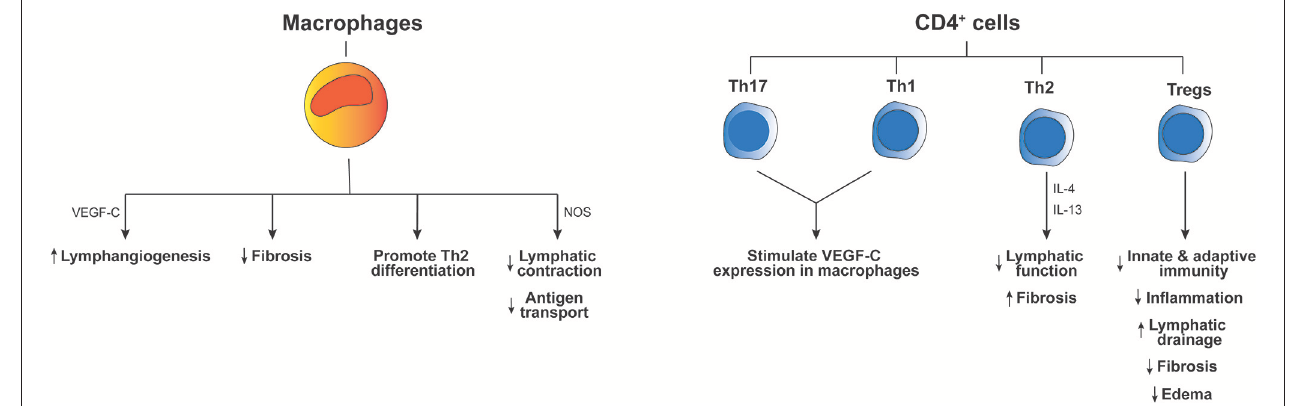
FIGURE 1 | Effects of immune cells on the pathogenesis of lymphedema. The diagram indicates how different immune cell types influence inflammation and other aspects of lymphedema pathology. Key molecular mediators produced by these cells types, which have been reported to drive the outcomes listed at the bottom of the figure, are indicated next to the long arrows. “Th” denotes T-helper cells, “Tregs” regulatory T cells, “IL” interleukin and “NOS” inducible nitric oxide